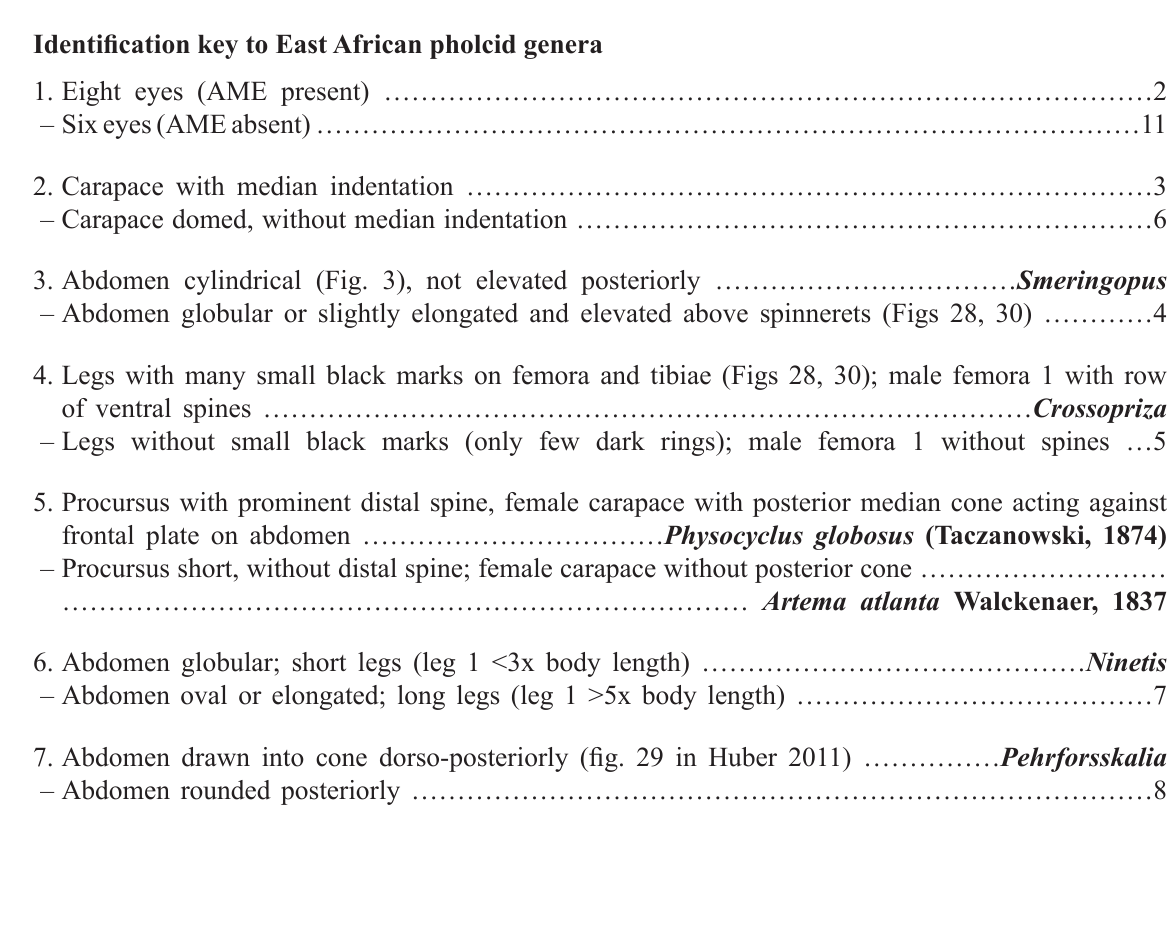
Identification key to East African pholcid genera